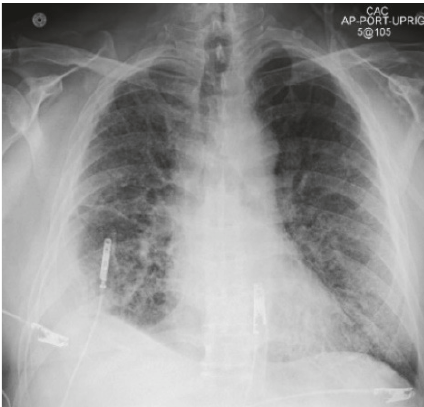
Figure 6: Anteroposterior chest X-ray 10 days after acute exacer- bation and treatment with glucocorticoids. Right pleural effusion resolved with improvement in interstitial